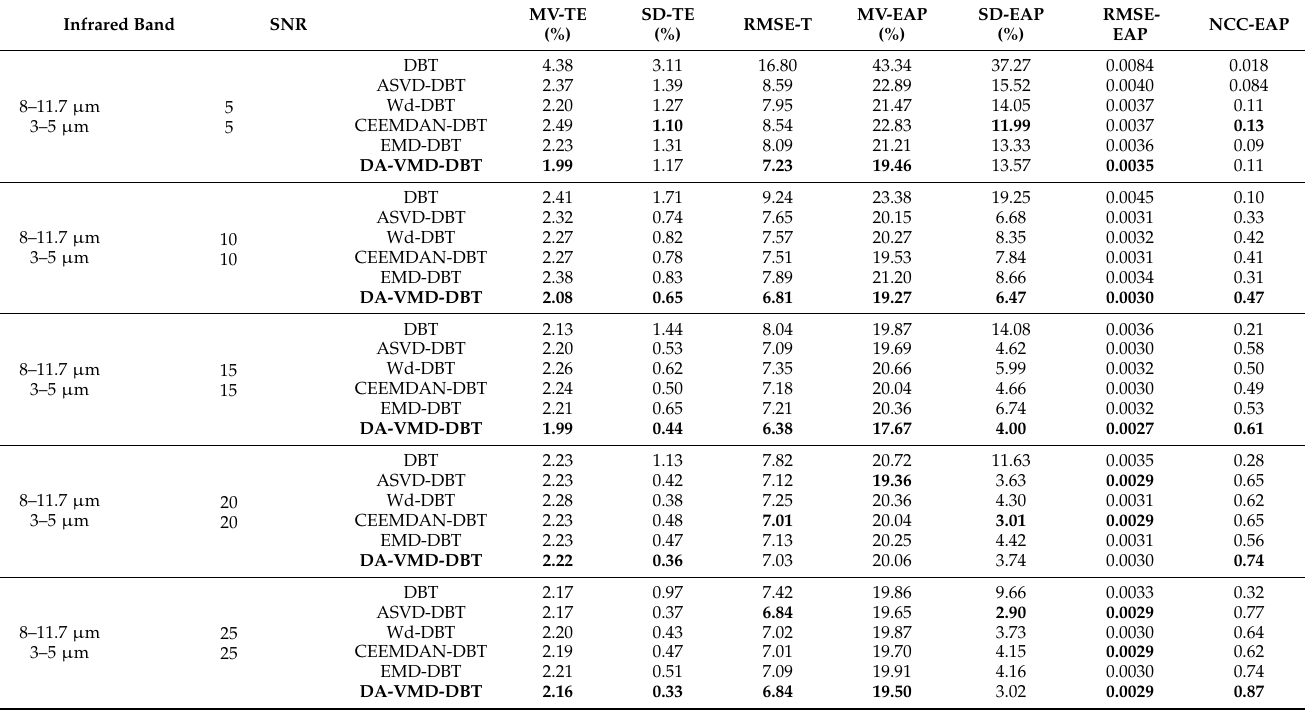
Table 10. The results of evaluation indexes of the feature extraction of experiment data (8–11.7/3– 5 µ